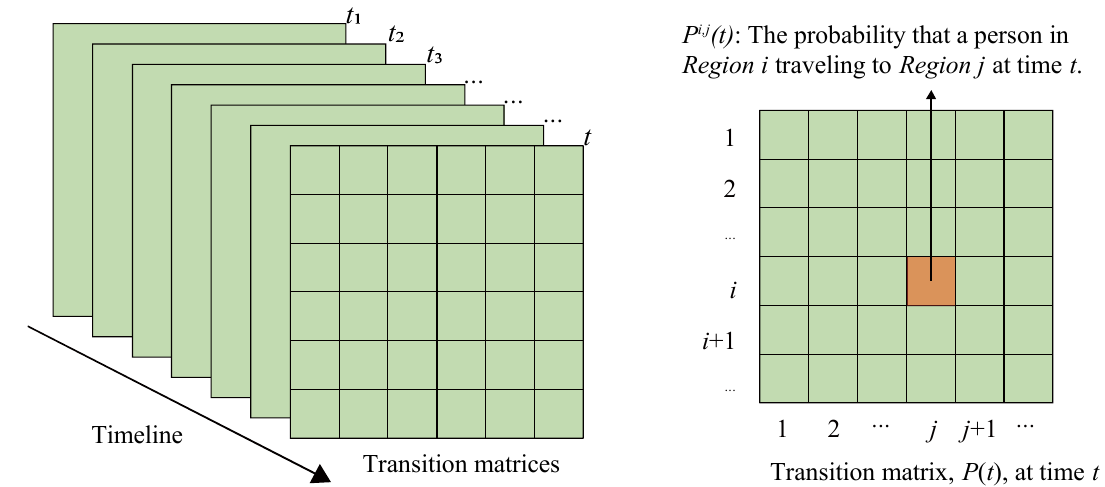
Figure 5. Time ‐ varying location transition matrices. Figure 5. Time-varying location transition